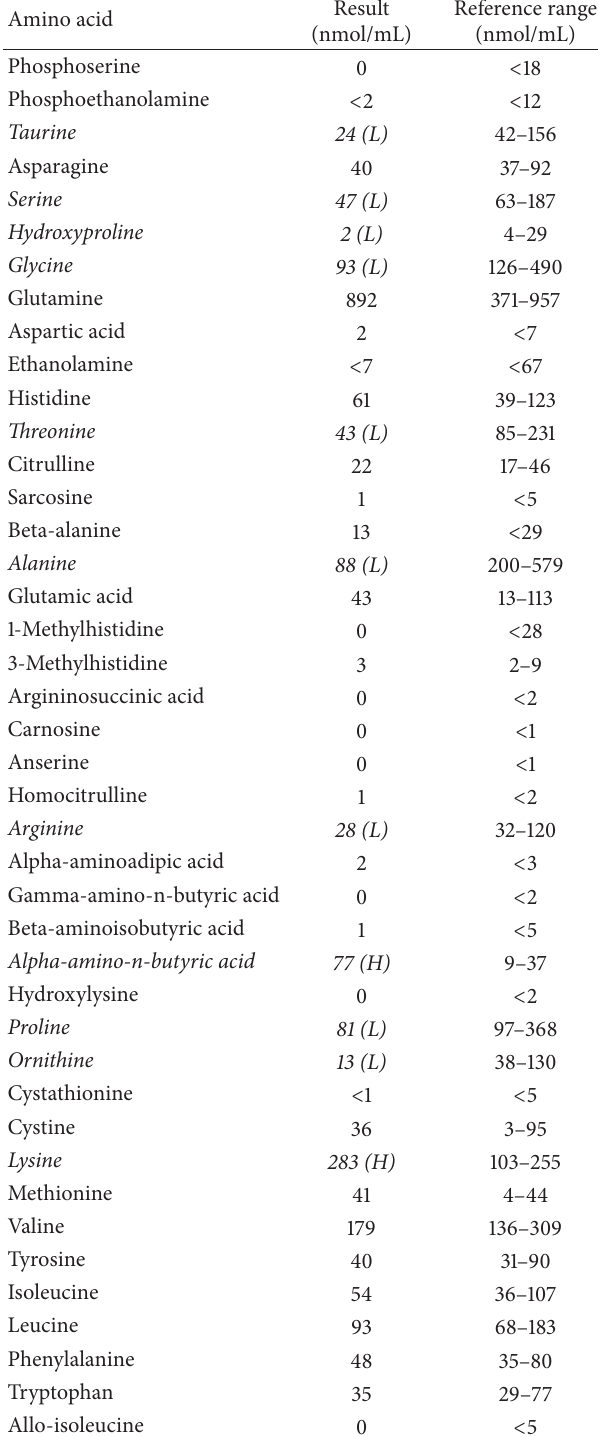
Table 1: Results of serum amino acid